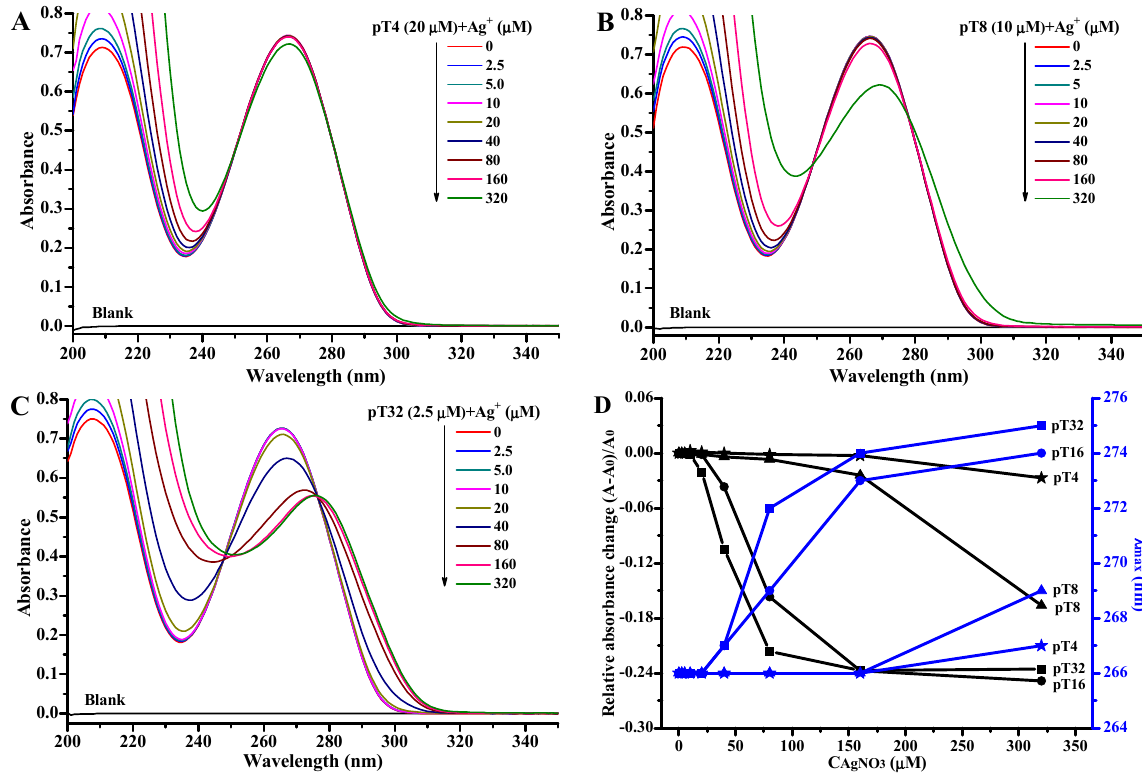
Figure 2. UV absorption spectra of 20 μ M T4 ( A ), 10 μ M T8 ( B ), and 2.5 μ M T32 ( C ) solutions in the absence and presence of 2.5, 5.0, 10, 20, 40, 80, 160, and 320 μ M AgNO 3 . ( D ) Plots of absorbance change (left, black) and wavelength (right, blue) at the maximum absorption against the concentration of AgNO 3 for 20 μ M T4 (star), 10 μ M T8 (uptriangle), 5.0 μ M T16 (circle), and 2.5 μ M T32 (square). The conditions are the same as those for Figure 1.